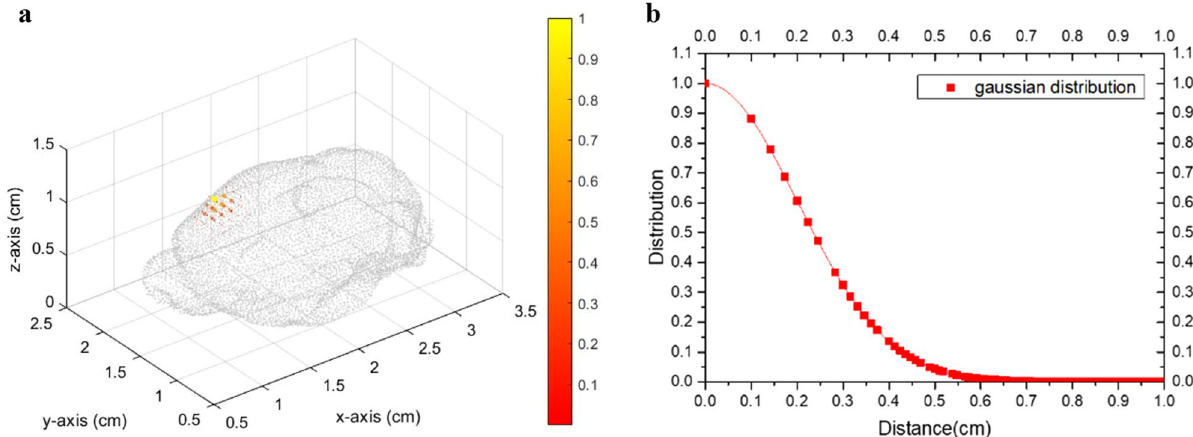
Figure 2. ( a ) Gaussian distribution of magnetic particles and ( b ) their distribution plot with a sigma of 0.1